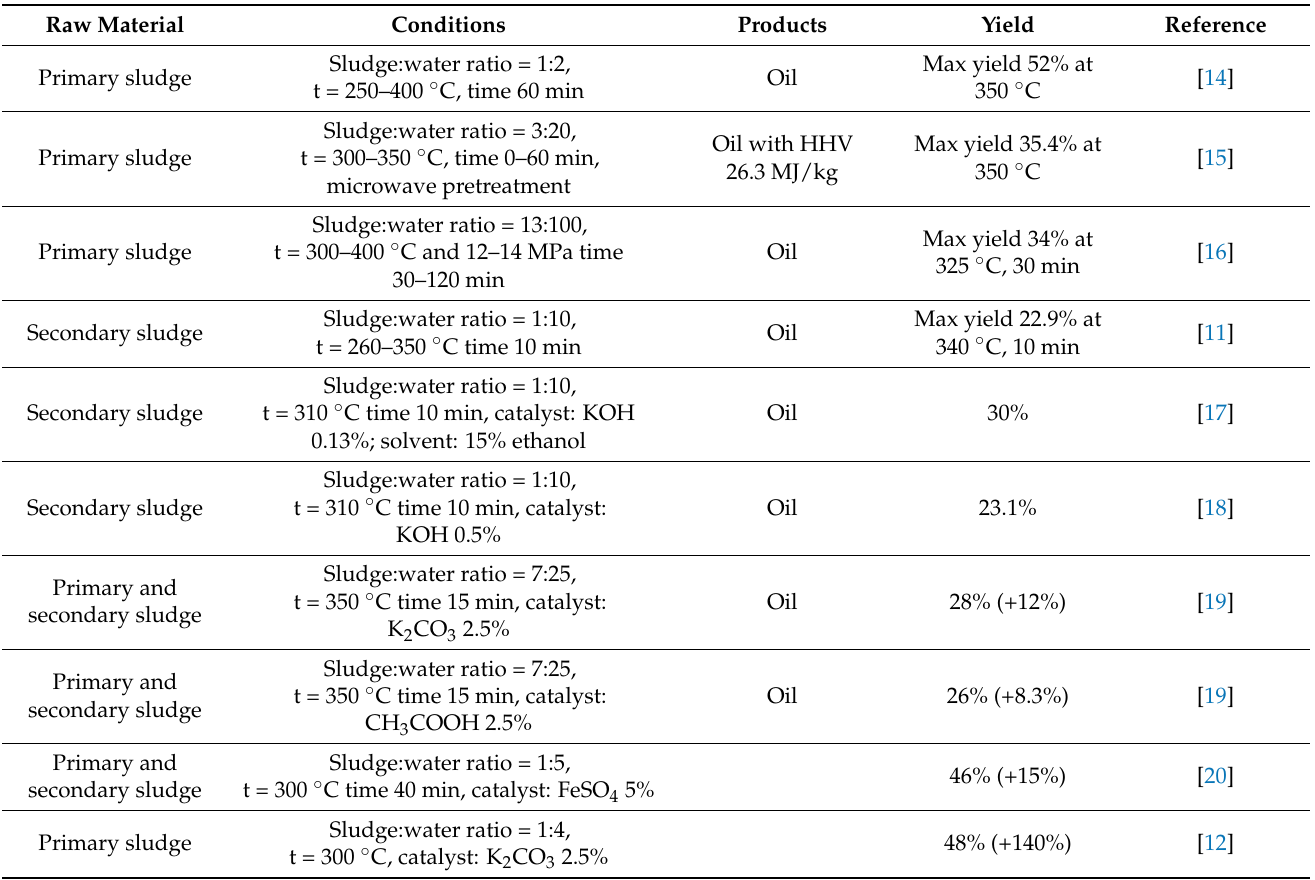
Table 1. Review of sewage sludge hydrothermal liquefaction conversion practices. Raw Material